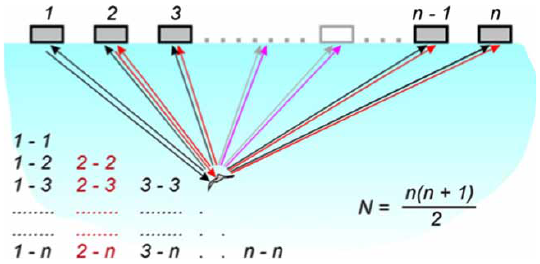
Fig. 2. General schematic of measuring antenna and matrix, illustrating how image is created (Samokrutov et al . 2006)